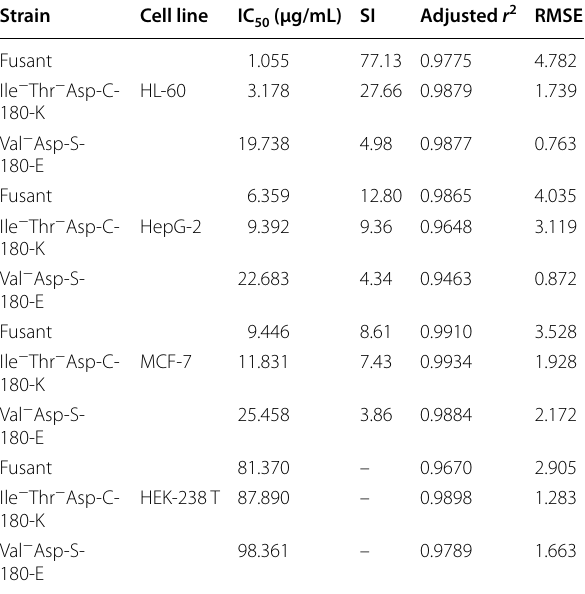
HL-60 Human myeloid lymphoma, HepG-2 Hepatocellular carcinoma, MCF-7 Human breast carcinoma